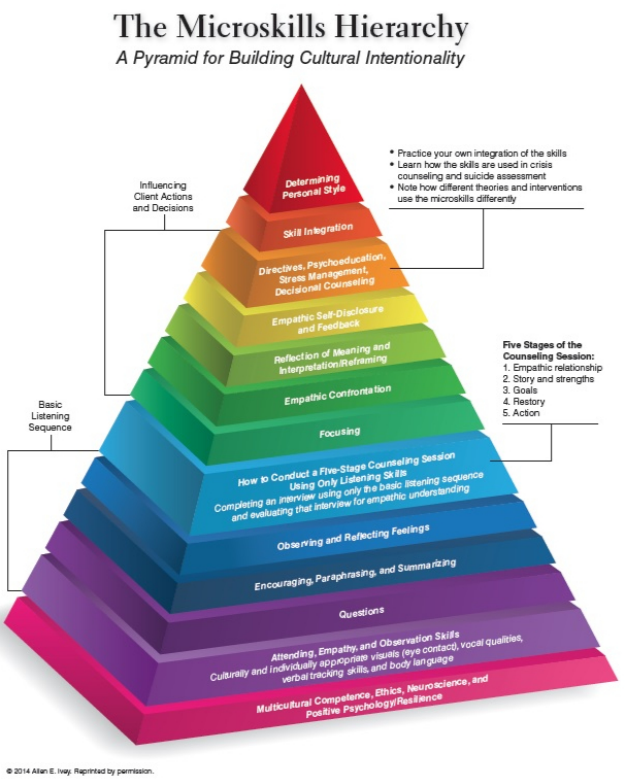
FFigigururee 1.1. MicrMicroskillsoskills HierHierararchchyy Reprinted with